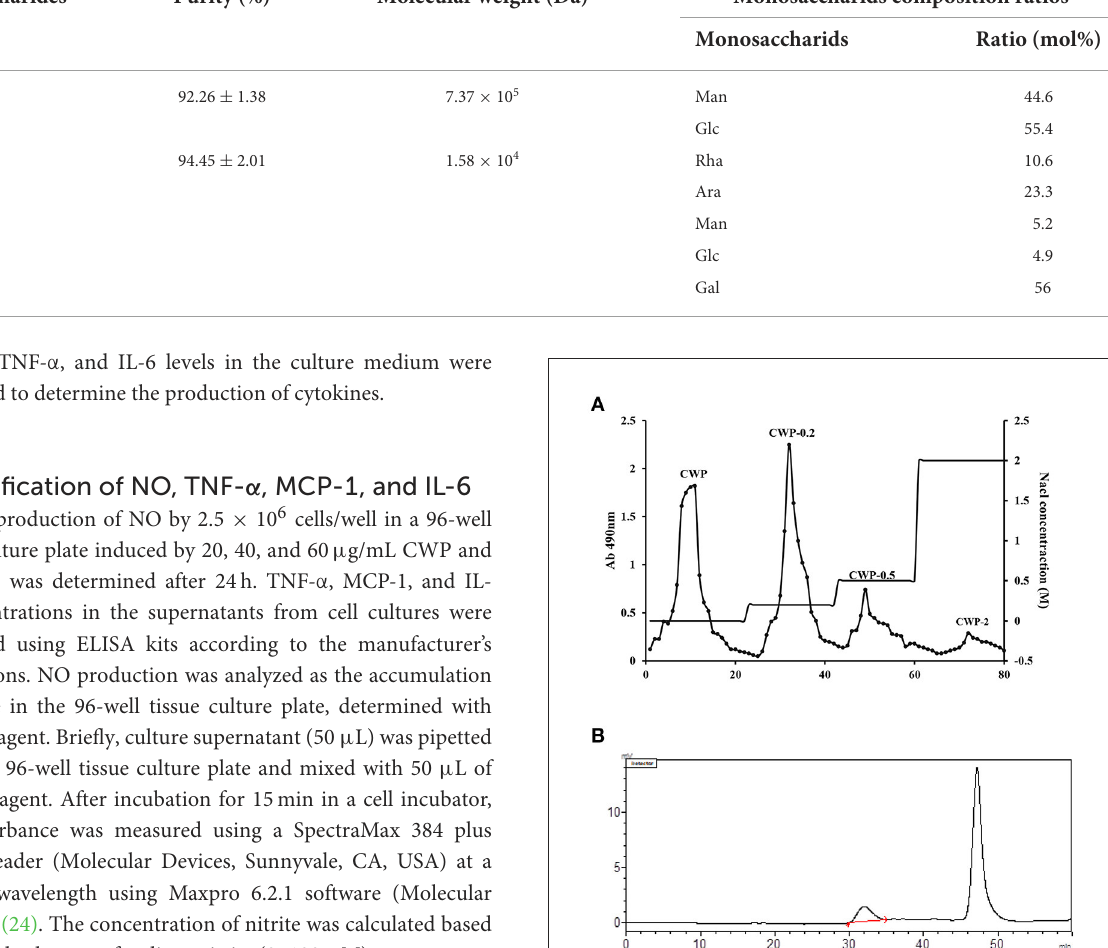
TABLE 1 Purity, molecular weight, and monosaccharids composition of CWP and CWP-0.2. Polysaccharides Purity (%) Molecular weight (Da) Monosaccharids composition ratios